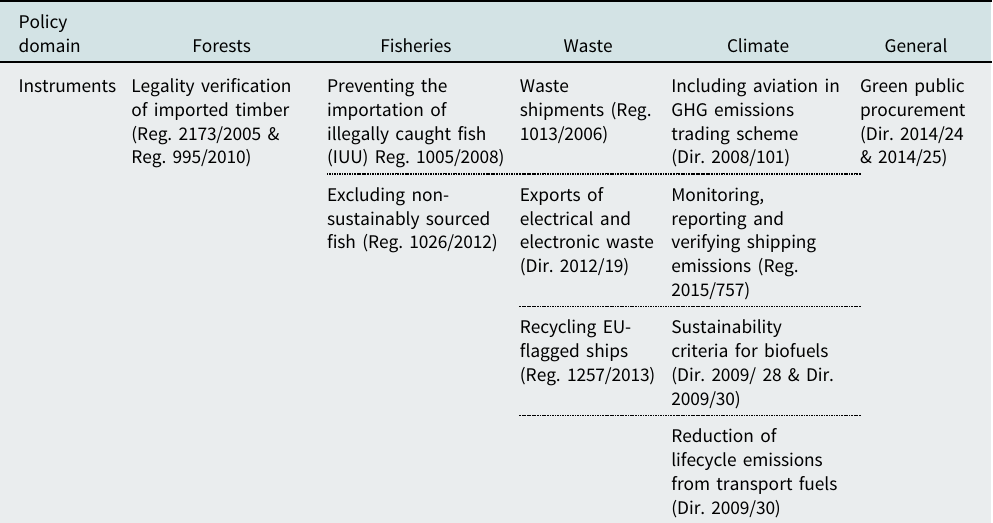
Table 3: EU Environmental Measures Giving Rise to Territorial